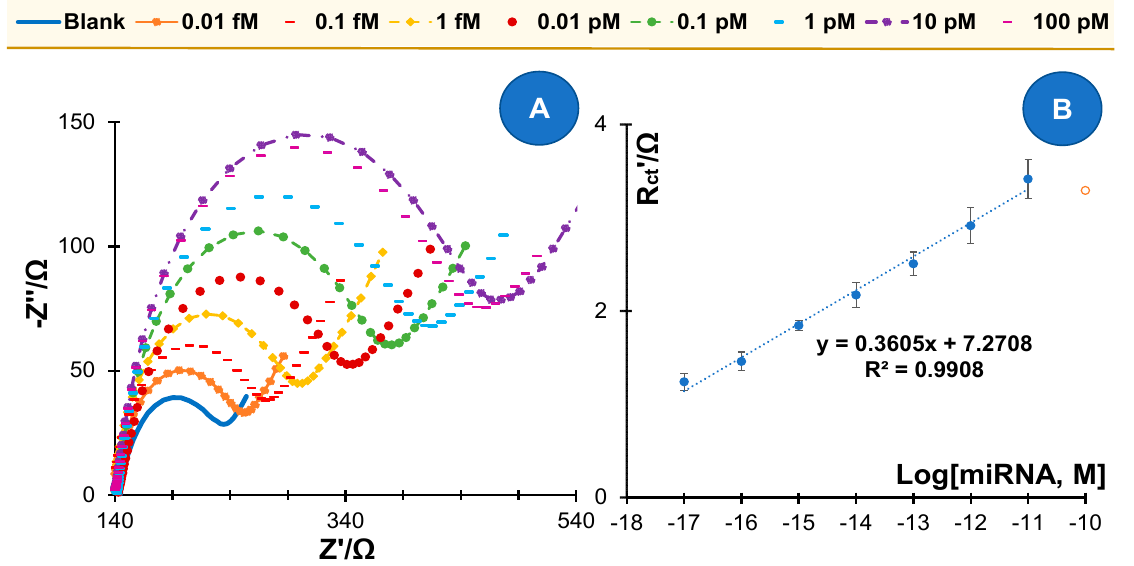
Figure 6. Calibration of the miRNA 21-5p biosensor in serum background. ( A ) Nyquist plots; ( B ) and the corresponding calibration curve in 5.0 × 10 − 3 M [Fe(CN) 6 ] 3 − and 5.0 × 10 − 3 M [Fe(CN) 6 ] 4 − , in standard solutions prepared in a 1000-fold diluted human serum and using relative Rct data.